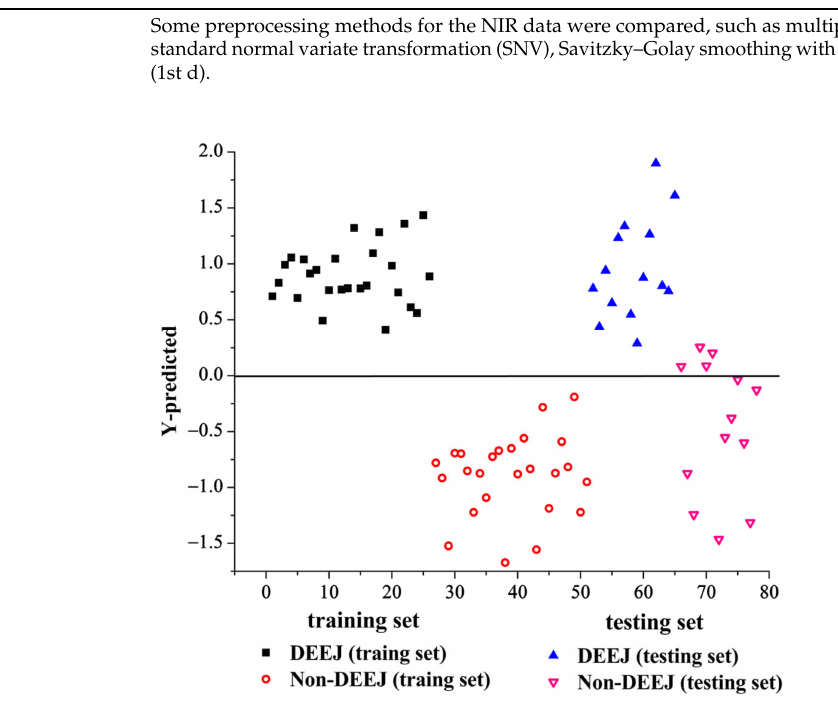
Figure 4. The PLS-DA model using the raw NIR